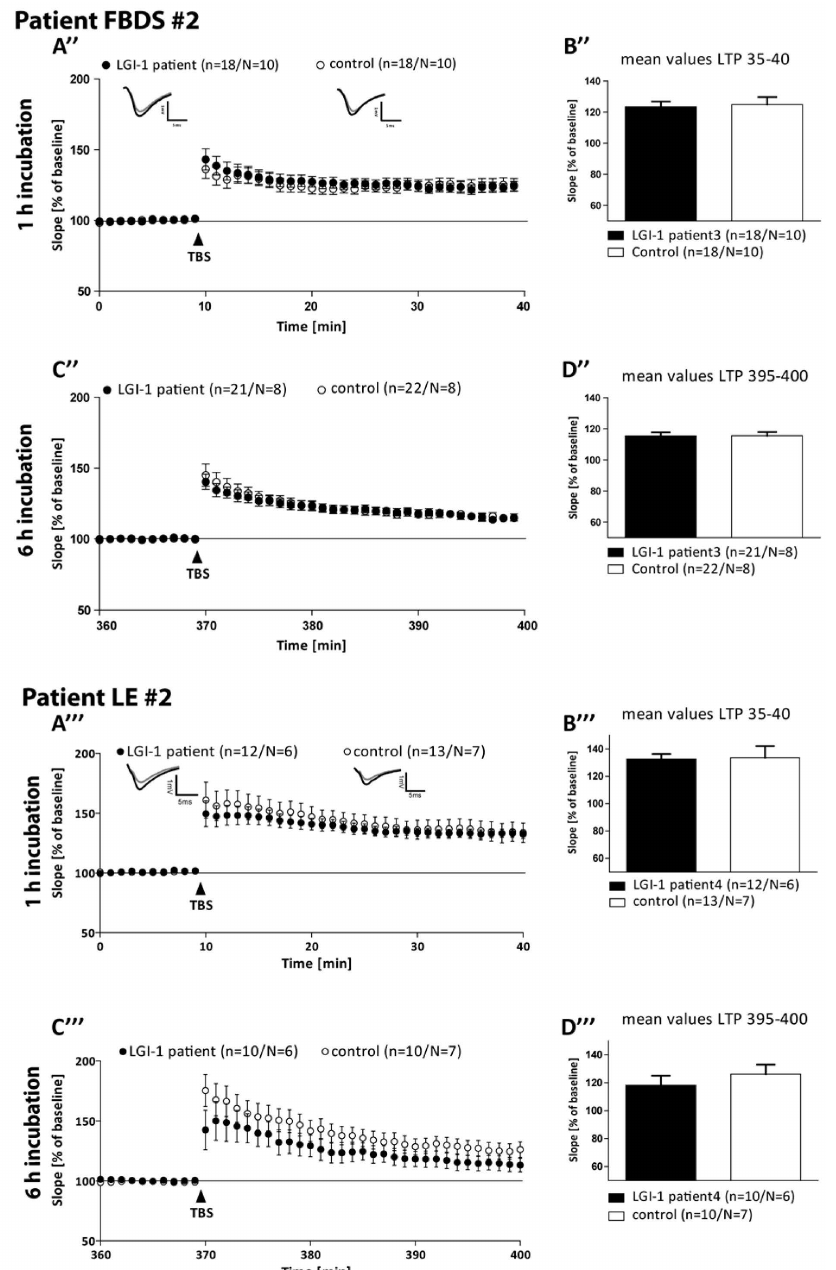
Figure 2. Field excitatory postsynaptic potentials (fEPSPs) of acute hippocampal slices of C57Bl/6- GFP mice treated with control serum (open circles) or with anti-LGI1- autoantibodies of four different patients (black circles) were recorded in the CA1 region by stimulating the Schaffer collateral axons of area CA3 at a frequency of 0.1 Hz. LTP was induced by the application of TBS after a 10 min baseline recording (arrowhead) in slices treated for 1 h or 6 h with control or anti-LGI1 ab of the respective patient. The LTP induction rate is shown as a percentage % of mean baseline slope. During the LTP measurement, slices were continuously perfused with either control or anti-LGI1 abs. ( A , A’ , A” , A”’ ) LTP recordings of slices treated with abs of individual patients for 1 h. ( B , B’ , B” , B”’ ) Bar graph depict- ing the averaged potentiation values of the last 5 min of individual LTP recordings. ( C , C’ , C” , C”’ ) LTP of acute slices continuously perfused for 6 h with individual patient abs. ( D , D’ , D” , D”’ ) Quantifi- cation of the last 5 min of the LTP recording after long-term ab application. All data are indicated as the mean ± SEM, analyzed by student’s t -test. * p < 0.05, n = number of recorded slices, N = number of animals; significant results are marked with a red